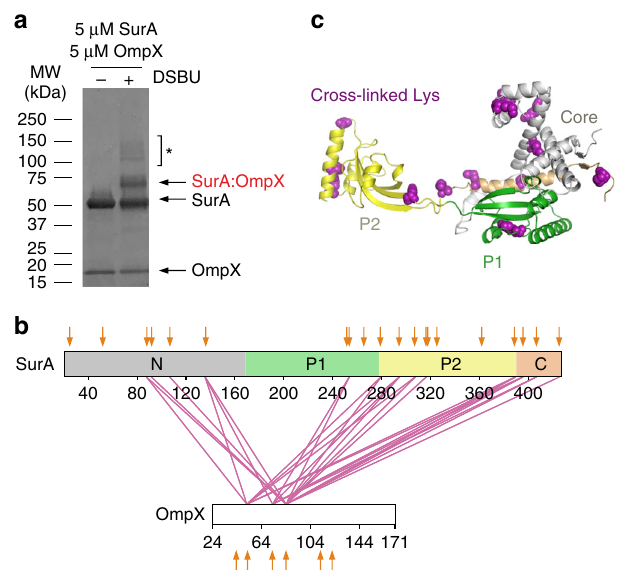
Fig. 4 Multi-site binding of OmpX to SurA. a SDS-PAGE analysis of DSBU cross-linked SurA-OmpX. Note that the species indicated with an asterisk (*) are higher order cross-linked species of mass corresponding to multiple SurA molecules bound to OmpX, consistent with multivalent binding observed previously 46 . These were not analysed further here. Source data are provided as a Source Data fi le. b Inter-molecular cross-links detected in the SurA-OmpX complex. The location of all Lys residues are indicated with orange arrows. c Crystal structure of SurA (PDB 1M5Y 27 ). Purple spheres indicate identi fi ed cross-link sites (Supplementary Table 7). Samples contained 5 µ M SurA, 5 µ M OmpX, 0.24 M urea, 50 µ M – 2 mM DSBU, in 10 mM potassium phosphate buffer, pH 8.0, 25 °C. A representative mass spectrum for each cross-link can be found in Supplementary Data